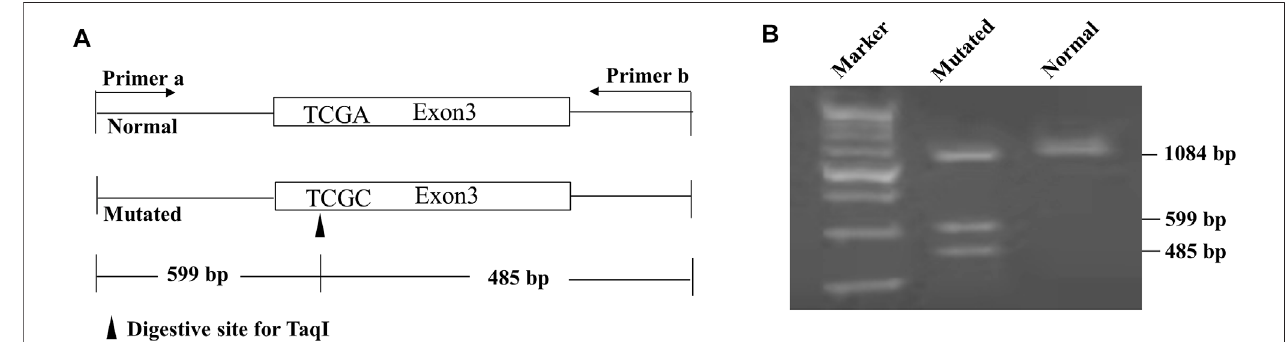
FIGURE 2 | Novel approach developed for the screening of the SLC10A1 variant c.665T > C (p. Leu222Ser). (A) schematic diagram of the PCR-RFLP approach. The mutated SLC10A1 allele hadaTaqIrestrictionenzymesite and produced the599and 485 bpfragmentsfrom the1,084 bpbandfollowing enzymatic digestion. (B) Gel electrophoresis showed that the heterozygote of the variant c.665T > C (p. Leu222Ser) had three bands of 1084, 599, and 485 bp, while the wildtype had only one band of 1084 bp.